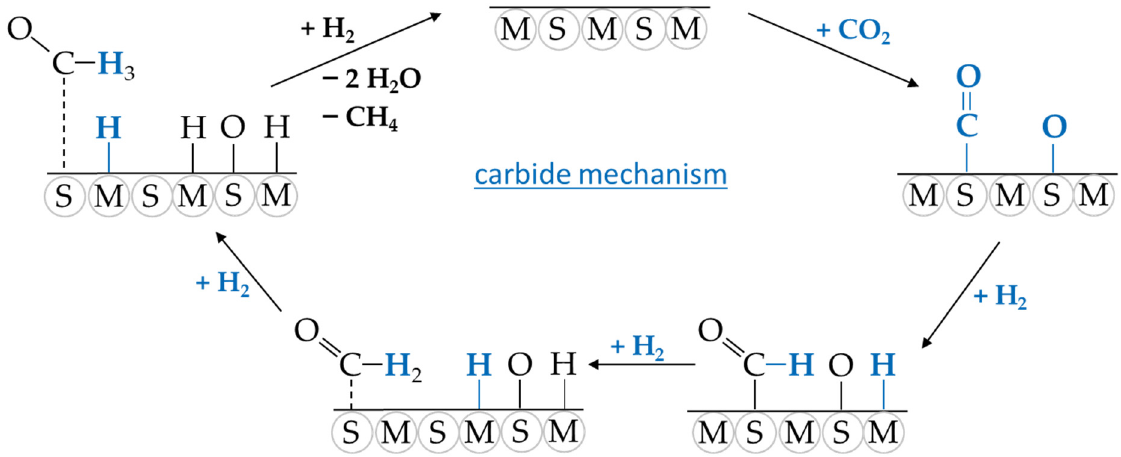
Figure 2. Proposed elementary steps with M = active metal and S = support for H 2 -assisted carbide mechanism [34].